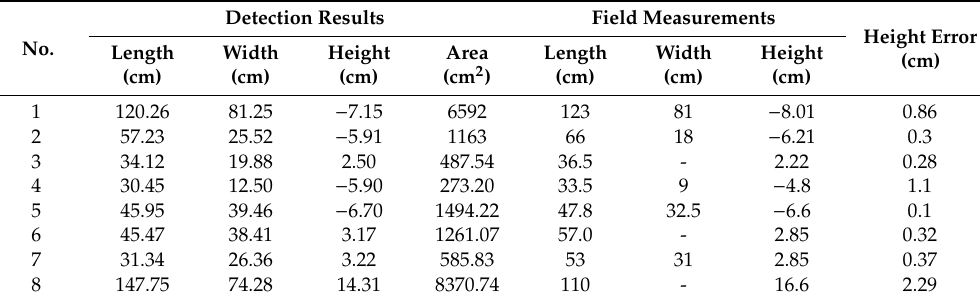
Figure 21. Detection result. Red marks road bulges. Blue marks road cavities. Table 8. Extracted distress features and comparison with field measurements.